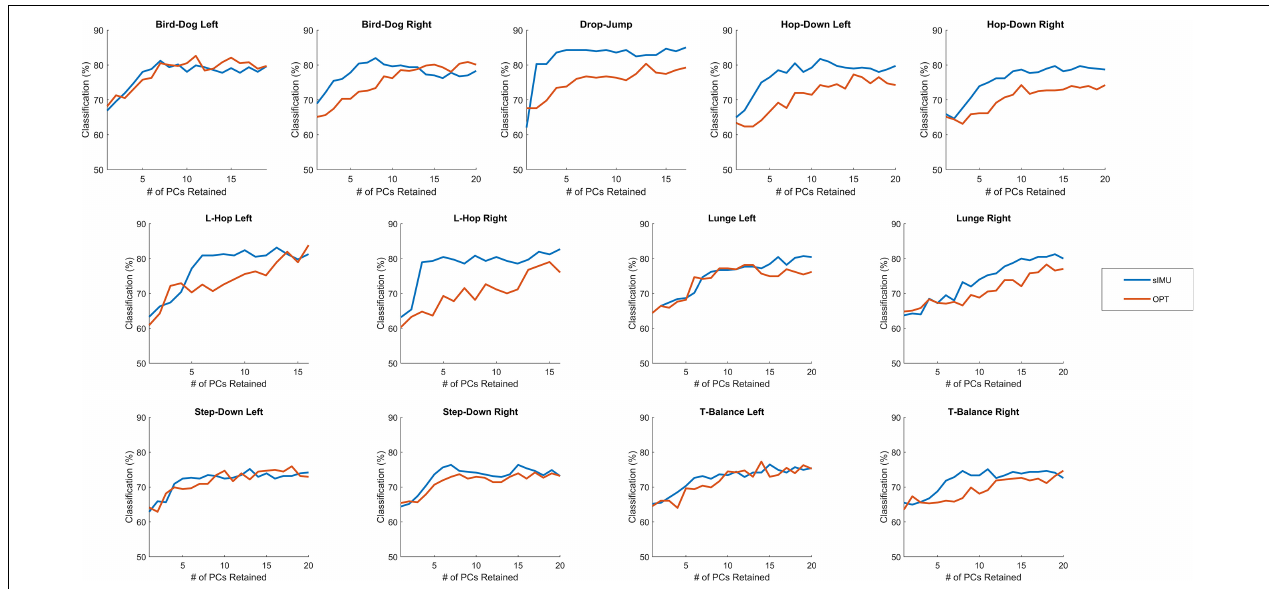
FIGURE 4 | The percent of correctly classified athletes as either elite or novice for when 1 to the total number of PCs retained were retained for the linear discriminant analysis with leave-one-out validation when using OPT and sIMU